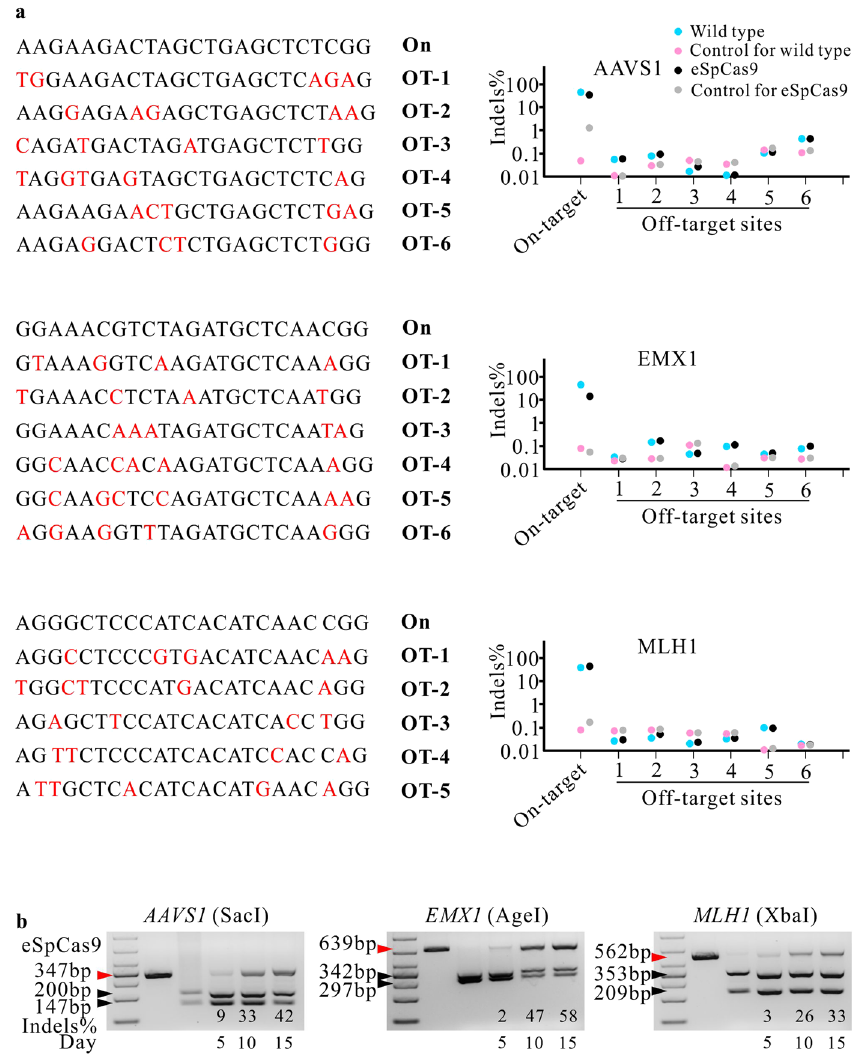
Figure 5. Analysis of off-target cleavage by targeted deep-sequencing. ( a ) The potential off-target sequences are shown on the left; the indel rates are shown on the right. On, on target sequence; OT, off-target sequence. The unmatched nucleotides are shown in red. ( b ) RFLP analysis of eSpCas9 cleavage at AAVS1 , EMX1 and MLH1 sites. Red triangles indicate the epiCRISPR-modified PCR bands; black triangles indicate the unmodified PCR